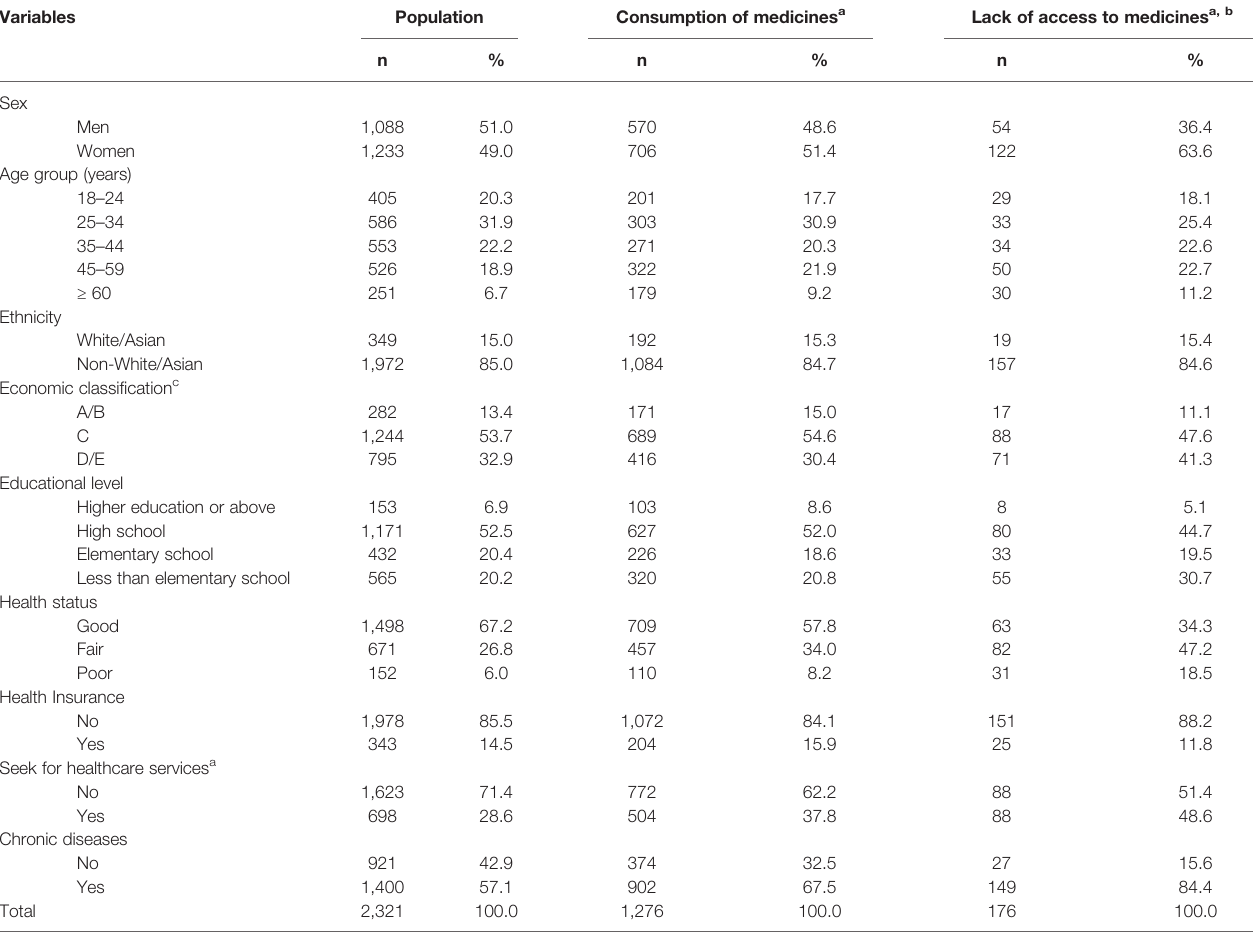
TABLE 1 | Main characteristics of the participants and consumption and lack of access to medicines among the adult population of Manaus in 2019 (N=2,321), adjusted for the complex sampling design.